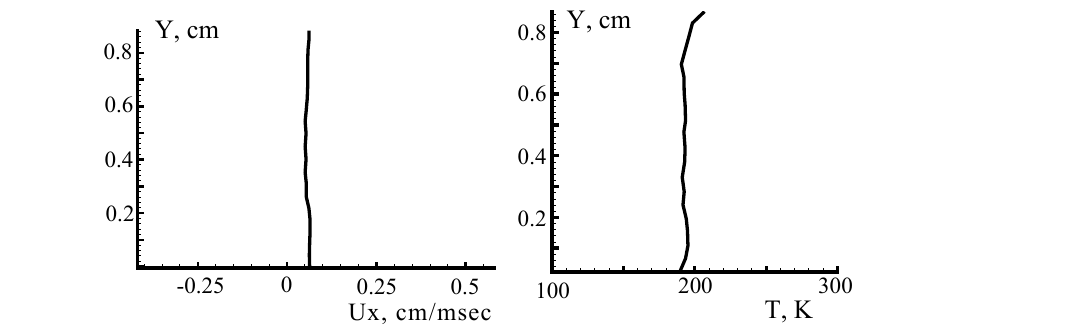
u (a) and temperature T (b) across the compacted region of the sample for the x